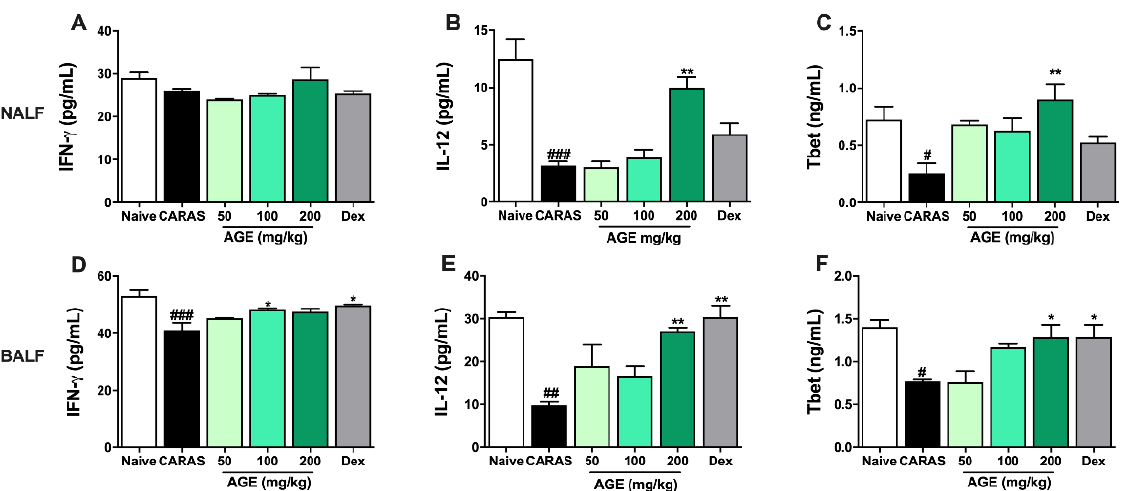
Figure 6. AGE increased TH1 cytokines and TH1 transcription factor in NALF and BALF. The levels of ( A ) IFN- γ, ( B ) IL-12, and ( C ) T-bet in NALF. The levels of ( D ) IFN- γ, ( E ) IL-12, and ( F ) T-bet in BALF. The levels of IL-12 and T-bet in NALF and the levels of IFN- γ , IL-12, and T-bet in BALF were significantly improved by AGE. All results are shown as the mean ± SD (n = 6 per group). # Compared to naive, * compared to CARAS. ### p < 0.001; ## , ** p < 0.01; # , * p < 0.05. CARAS = combined allergic rhinitis and asthma syndrome; AGE = Artemisia gmelinii extracts; Dex = dexamethasone; NALF = nasal lavage fluid; BALF = bronchoalveolar lavage fluid; IL = interleukin. 2.7. AGE Decrease TH2 Cytokines and TH2 Transcription Factor in NALF and BALF To investigate the impact of AGE on the modulation of T helper homeostasis, TH2 cytokines (IL-4, IL-5, and IL-13) and TH2 transcription factor (GATA-3) were estimated by ELISA assay. In NALF, the levels of IL-4, IL-5, IL-13, and GATA-3 were sharply GATA-3 was significantly alleviated by AGE 200 mg/kg and Dex 2.5 mg/kg, while IL-5 and IL-13 were notably decreased by AGE 100 and 200 mg/kg similarly with Dex 2.5 mg/kg (Figure 7A – D). Similar to NALF, the levels of IL-4, IL-5, IL-13, and GATA-3 in BALF were majorly raised in the CARAS group compared with the naive group. The level of IL-4 was greatly declined by the treatment of both AGE 100 and 200 mg/kg, while the level of IL-5 was markedly reduced in the administration of AGE 200 mg/kg. There was a downtrend in the levels of IL-13 and GATA-3 in the mice treated with AGE and Dex compared with CARAS mice (Figure 7E – H).